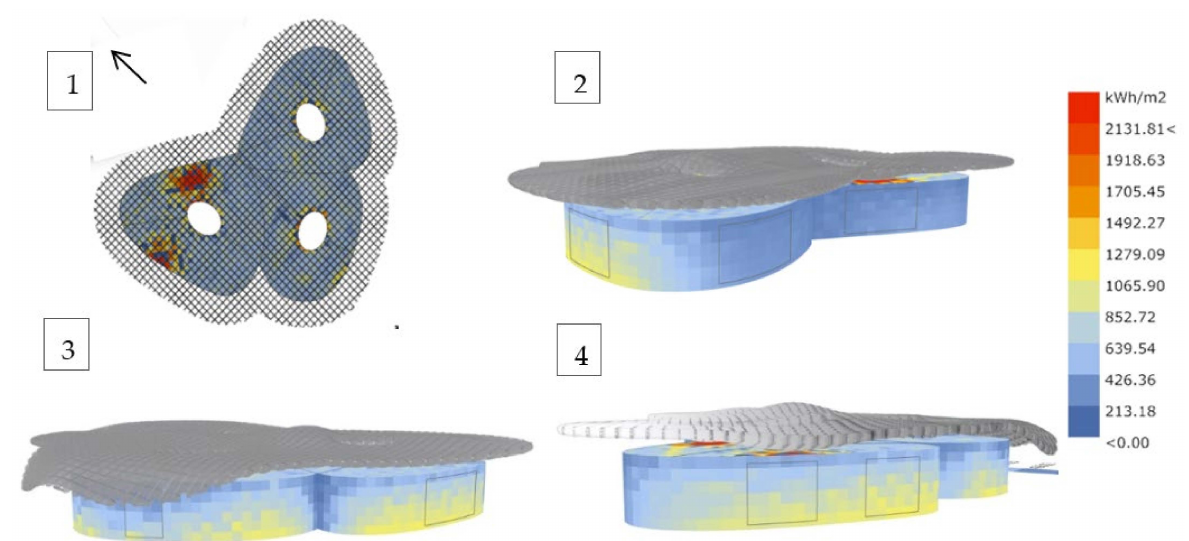
Figure 18. 3D views of the new design: ( a ) south view, ( b ) north view.